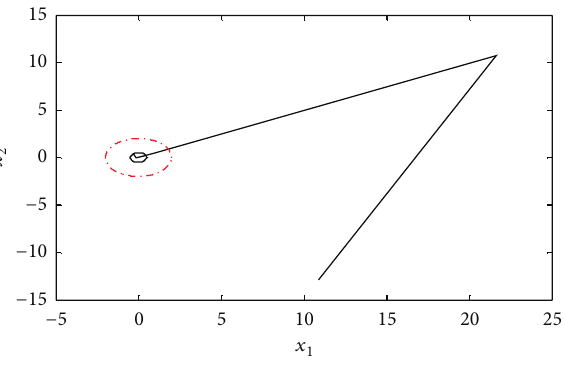
Figure 2: State trajectory of free MJS.